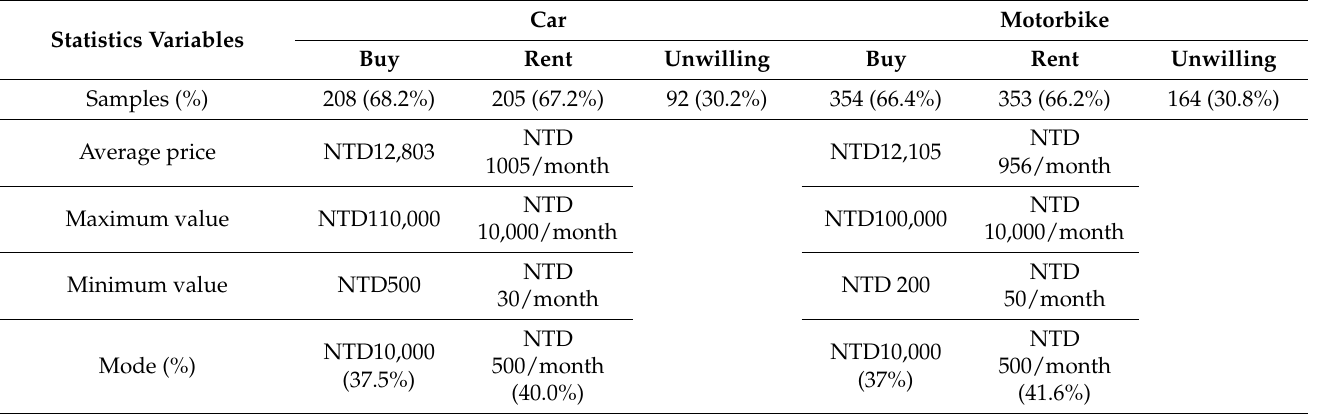
Table 8. Statistics on willingness to use and pay for the assumed alcohol